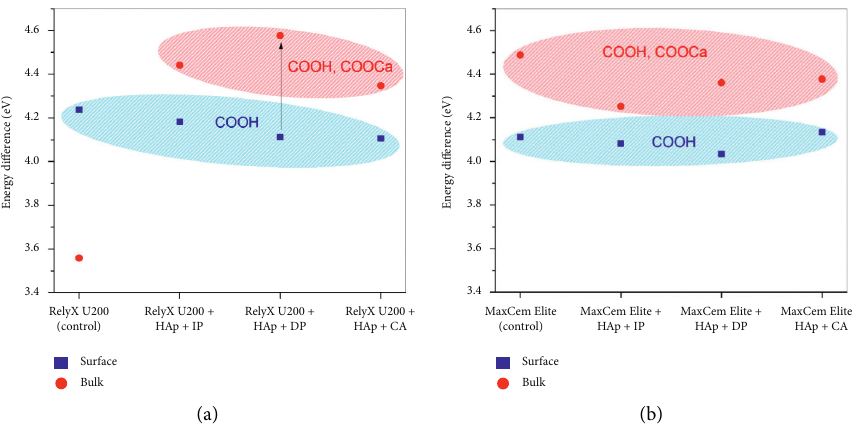
Figure 6: Binding energy difference between the C-H (284.6 eV, a fixed value for adventitious carbon) and COOH (near 286.6) bonds from the high-resolution C1s spectra. (a) Results from the RelyX U200 adhesives experimental groups. (b) Results from the Maxcem Elite adhesives experimental groups. The dots in blue are related to data extracted from the surface analysis, while those in red were extracted from the bulk. The arrow in (a) highlights the higher energy difference between the COOH and COOCa species in the RelyX U200+HAp +DP experimental group. Similar difference at lower energy was observed for the combination Maxcem Elite+HAp+DP, at lower binding energy. For Maxcem Elite, the highest binding energy of the carboxyl groups bonded to the calcium of HAp (COOCa) was found for the combination when the CA protocol was